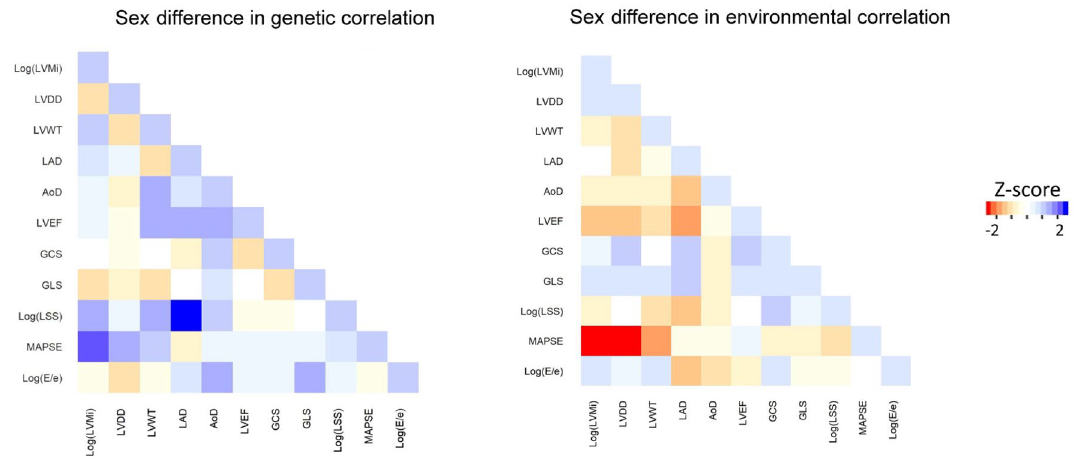
Figure 1. Sex differences in the genetic and environmental correlations among echocardiographic traits. Correlation values are represented on a color scale where blue represents higher correlation for men and red represents higher correlation for